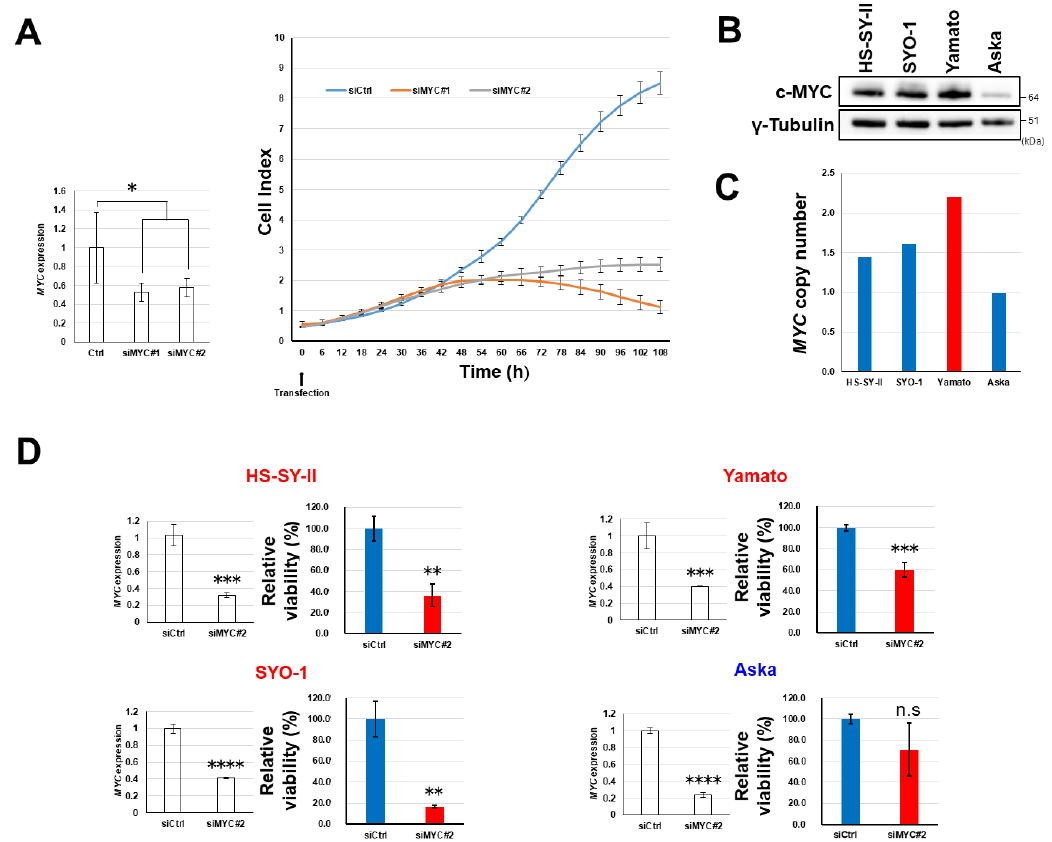
Figure 6. Dependence of synovial sarcoma cells on MYC . ( A ) Relative MYC expression (left) and real-time growth monitoring (right) of HS-SY-II cells transfected with control small interfering (siRNA) (siCtrl) and siRNA to MYC (siMYC#1 and #2). Data represent the mean MYC expression (normalized to ACTB ) (left) and cell index (right) ± S.D. of three replicates. * p < 0.05 (multiple t -test corrected using